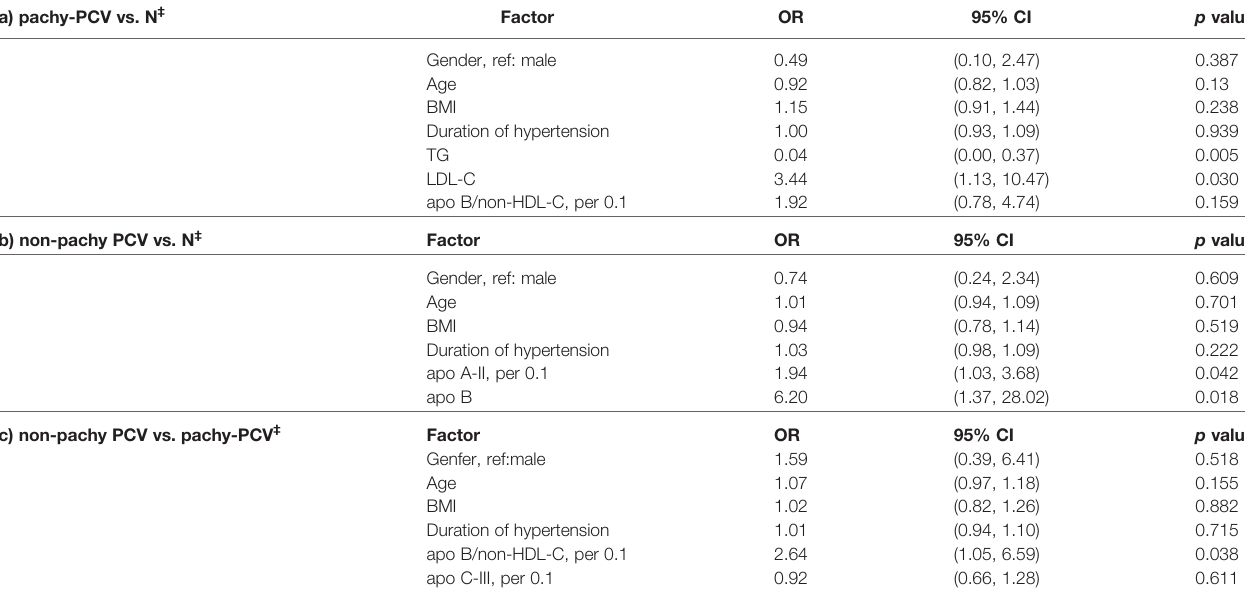
TABLE 6 | Comparisons in the lipid pro fi les and apolipoproteins between the subgroups of PCV (pachy- and nonpachy-) and control by multivariable logistic regression analysis. (a) pachy-PCV vs. N ‡